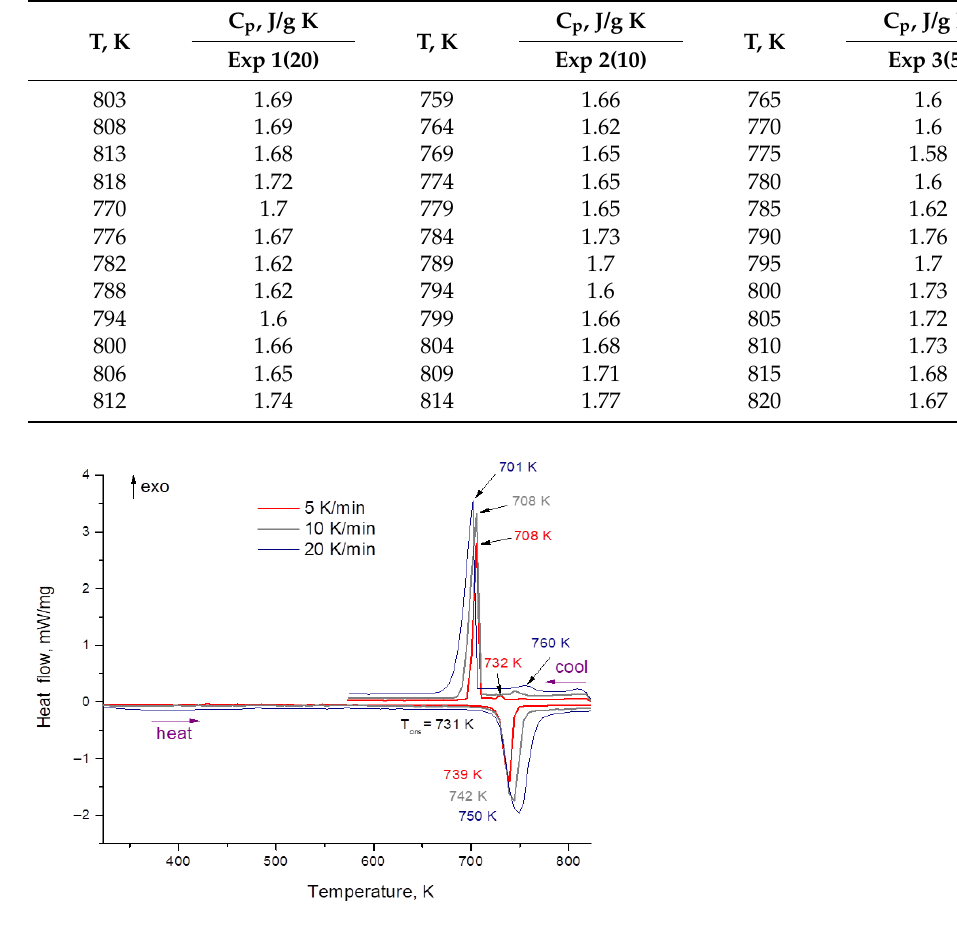
Figure 5. DSC results for FliNaK at different heating rates.